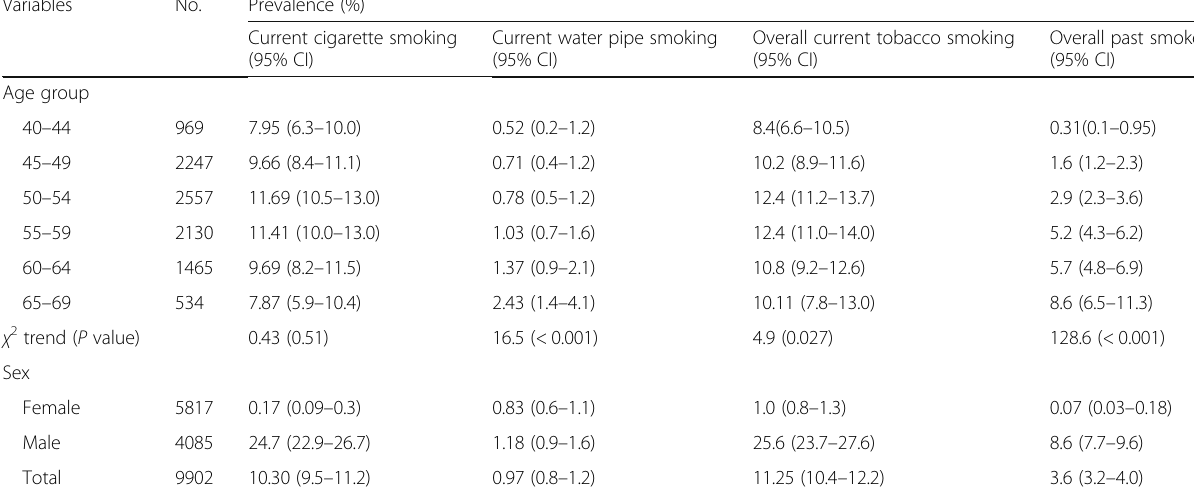
Table 1 Age- and sex-specific prevalence of current and past smoking according to a marginal model in Shahroud, Iran (2009 – 2014)